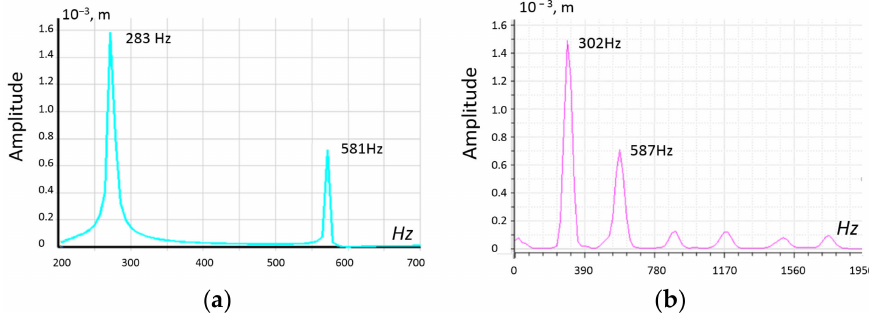
Figure 11. Result comparison, ( a ) numerical simulation and ( b ) experimental